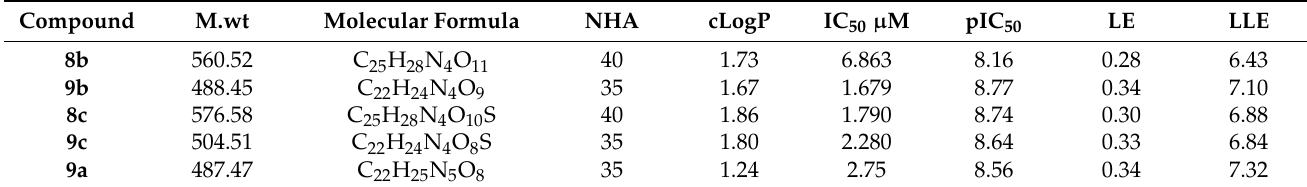
Table 3. Ligand efficiency of the best compounds against the NA of the H5N1